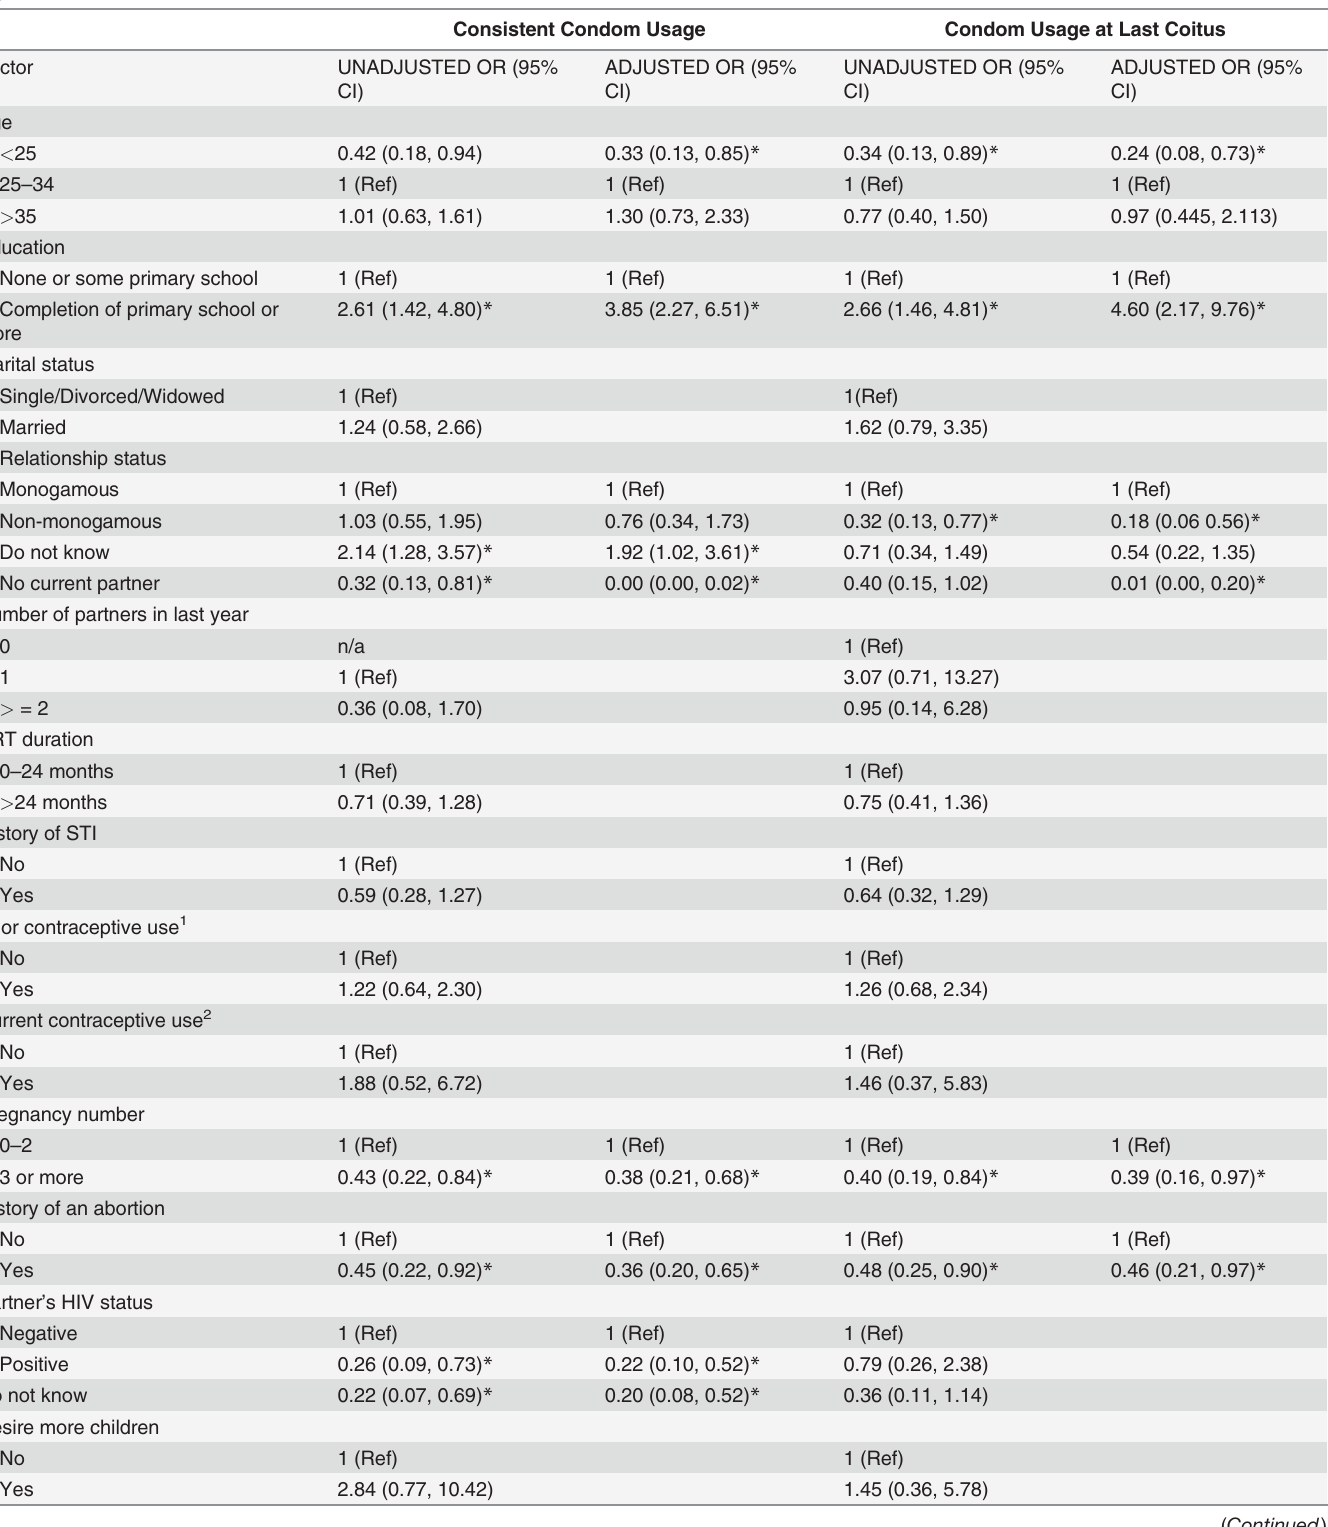
Table 3. Factors associated with consistent condoms in last year and condom usage at last intercourse, unadjusted and adjusted odds ratios with significant variables from bivariate evaluation included in the